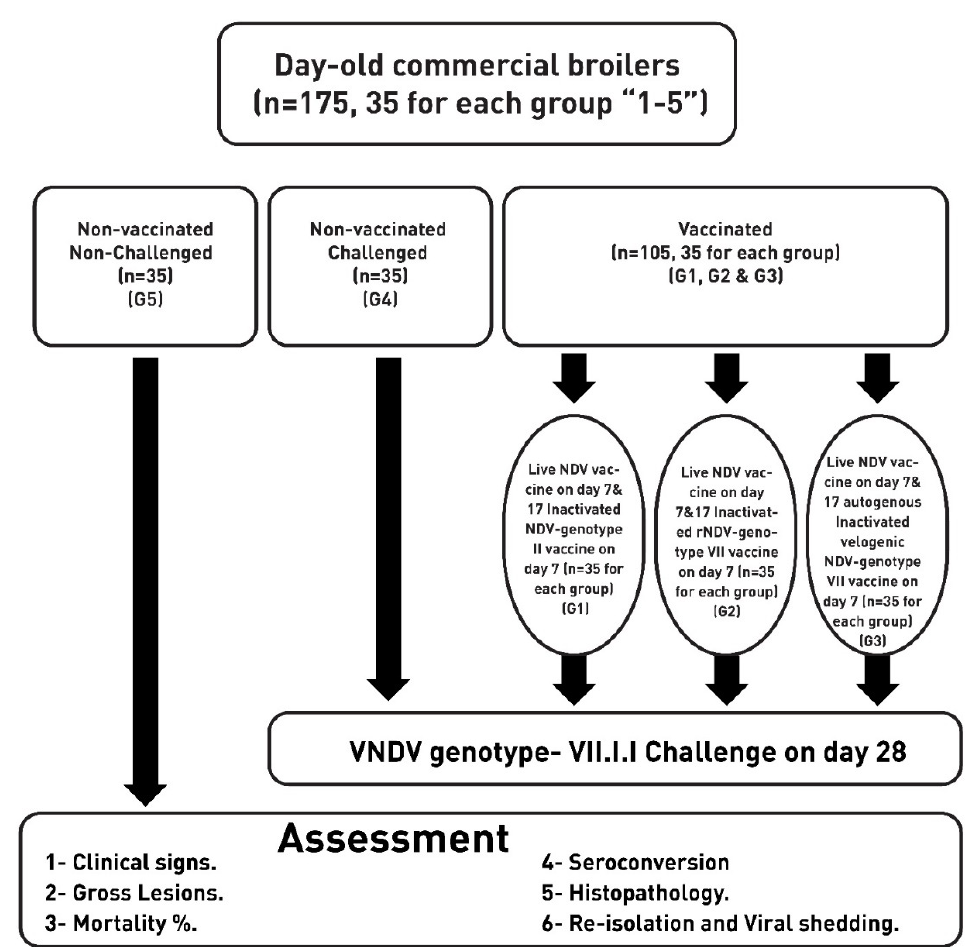
Figure 1. Experimental plan for assessment of inactivated NDV genotype II, inactivated rNDV genotype VII, and autogenous velogenic NDV genotype VII effectiveness against velogenic NDV-genotype VII.I.I (Accession No.:MG029120) challenge in broilers.